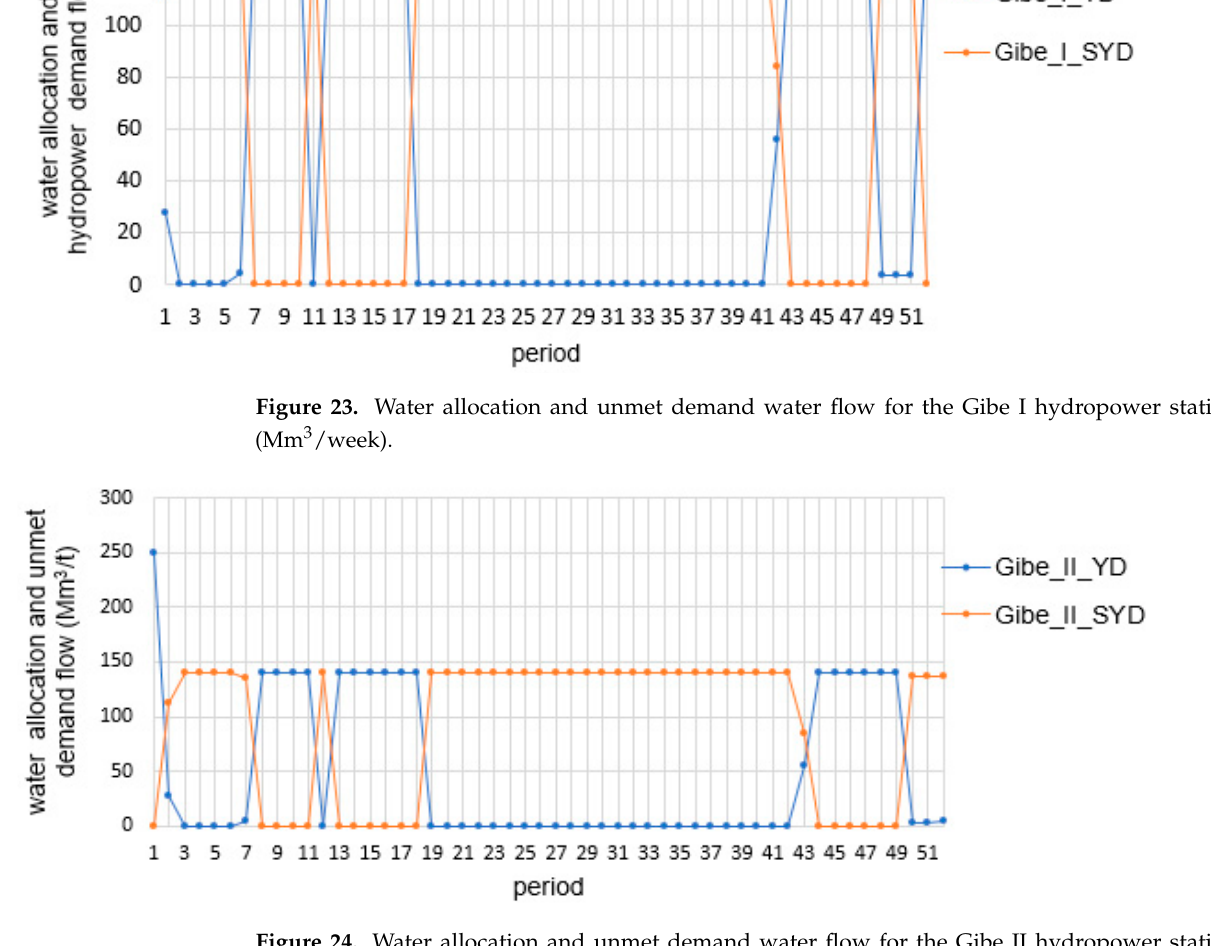
Figure 24. Water allocation and unmet demand water flow for the Gibe II hydropower station (Mm 3 /week).